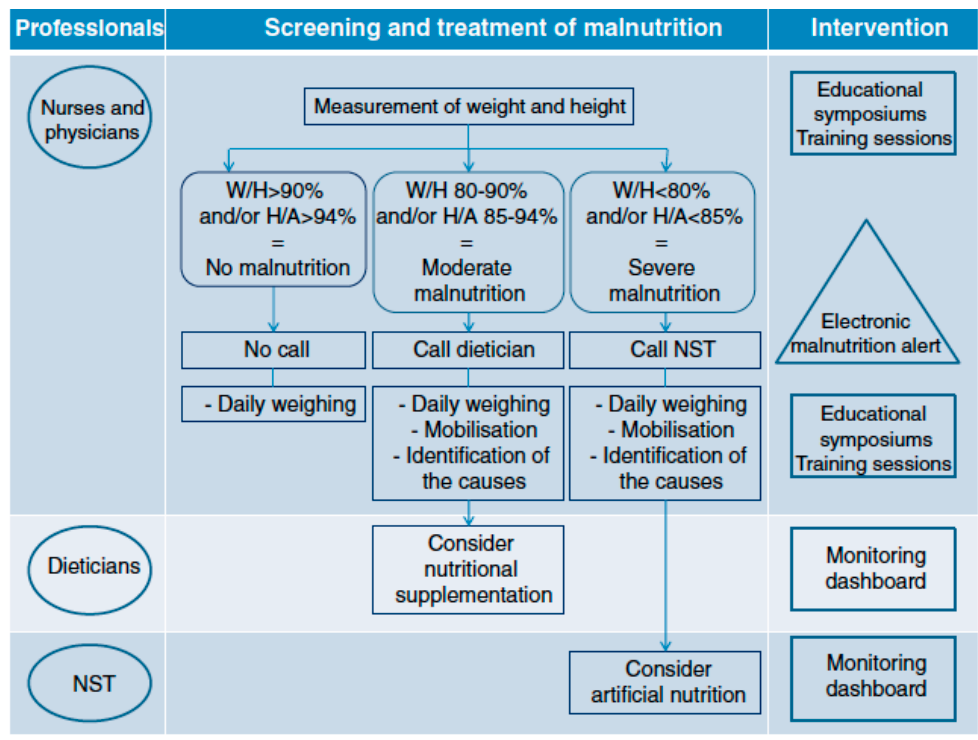
Figure 2. Components of the intervention as well as the target groups and the stages of nutritional treatment. Reproduced with permission according to the Creative Commons Public Domain Mark 1.0 Touzet S et al. [82]. BMC Health Services Research 2013.